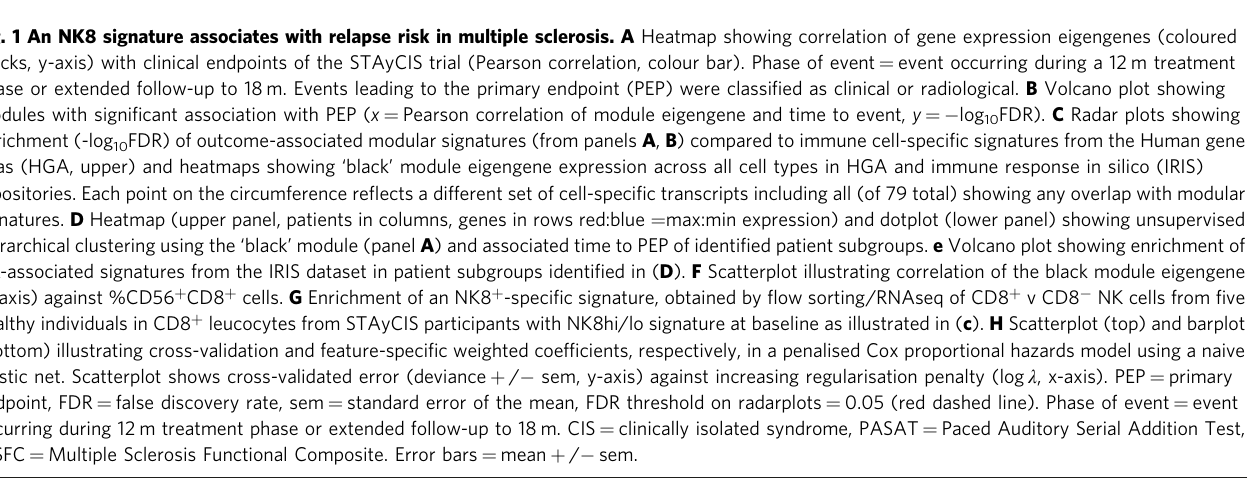
Fig. 1 An NK8 signature associates with relapse risk in multiple sclerosis. A Heatmap showing correlation of gene expression eigengenes (coloured blocks, y-axis) with clinical endpoints of the STAyCIS trial (Pearson correlation, colour bar). Phase of event = event occurring during a 12 m treatment phase or extended follow-up to 18 m. Events leading to the primary endpoint (PEP) were classi fi ed as clinical or radiological. B Volcano plot showing modules with signi fi cant association with PEP ( x = Pearson correlation of module eigengene and time to event, y = − log 10 FDR). C Radar plots showing enrichment (-log 10 FDR) of outcome-associated modular signatures (from panels A , B ) compared to immune cell-speci fi c signatures from the Human gene atlas (HGA, upper) and heatmaps showing ‘ black ’ module eigengene expression across all cell types in HGA and immune response in silico (IRIS) repositories. Each point on the circumference re fl ects a different set of cell-speci fi c transcripts including all (of 79 total) showing any overlap with modular signatures. D Heatmap (upper panel, patients in columns, genes in rows red:blue = max:min expression) and dotplot (lower panel) showing unsupervised hierarchical clustering using the ‘ black ’ module (panel A ) and associated time to PEP of identi fi ed patient subgroups. e Volcano plot showing enrichment of NK-associated signatures from the IRIS dataset in patient subgroups identi fi ed in ( D ). F Scatterplot illustrating correlation of the black module eigengene (x-axis) against %CD56 + CD8 + cells. G Enrichment of an NK8 + -speci fi c signature, obtained by fl ow sorting/RNAseq of CD8 + v CD8 − NK cells from fi ve healthy individuals in CD8 + leucocytes from STAyCIS participants with NK8hi/lo signature at baseline as illustrated in ( c ). H Scatterplot (top) and barplot (bottom) illustrating cross-validation and feature-speci fi c weighted coef fi cients, respectively, in a penalised Cox proportional hazards model using a naive elastic net. Scatterplot shows cross-validated error (deviance + / − sem, y-axis) against increasing regularisation penalty (log λ , x-axis). PEP = primary endpoint, FDR = false discovery rate, sem = standard error of the mean, FDR threshold on radarplots = 0.05 (red dashed line). Phase of event = event occurring during 12 m treatment phase or extended follow-up to 18 m. CIS = clinically isolated syndrome, PASAT = Paced Auditory Serial Addition Test, MSFC = Multiple Sclerosis Functional Composite. Error bars = mean + / −